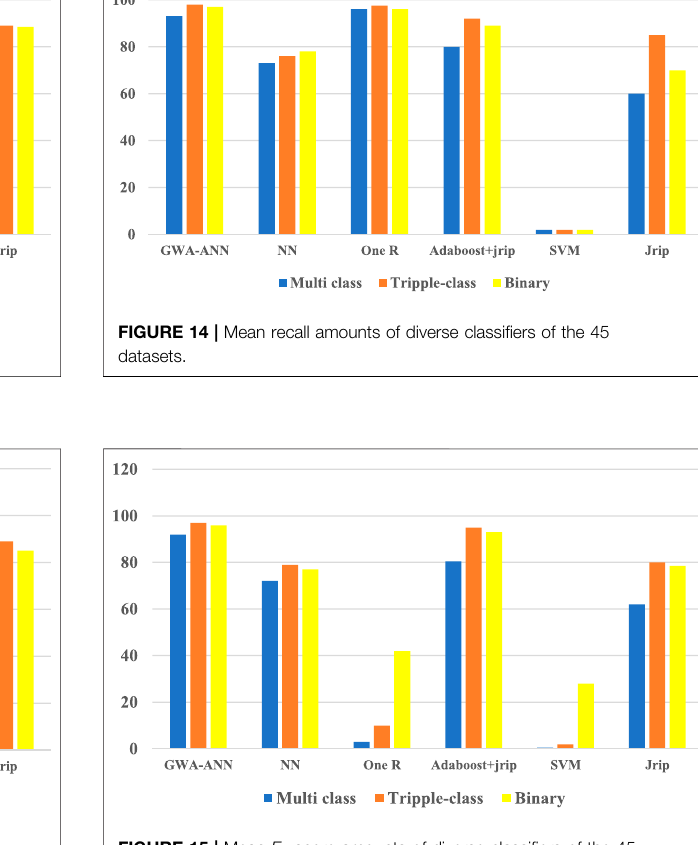
FIGURE 15 | Mean F 1 score amounts of diverse classi fi ers of the 45